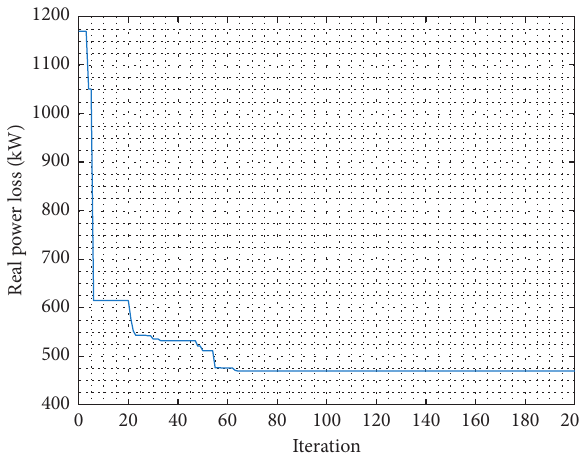
Figure 6: The convergence characteristic of power loss for the 84-bus